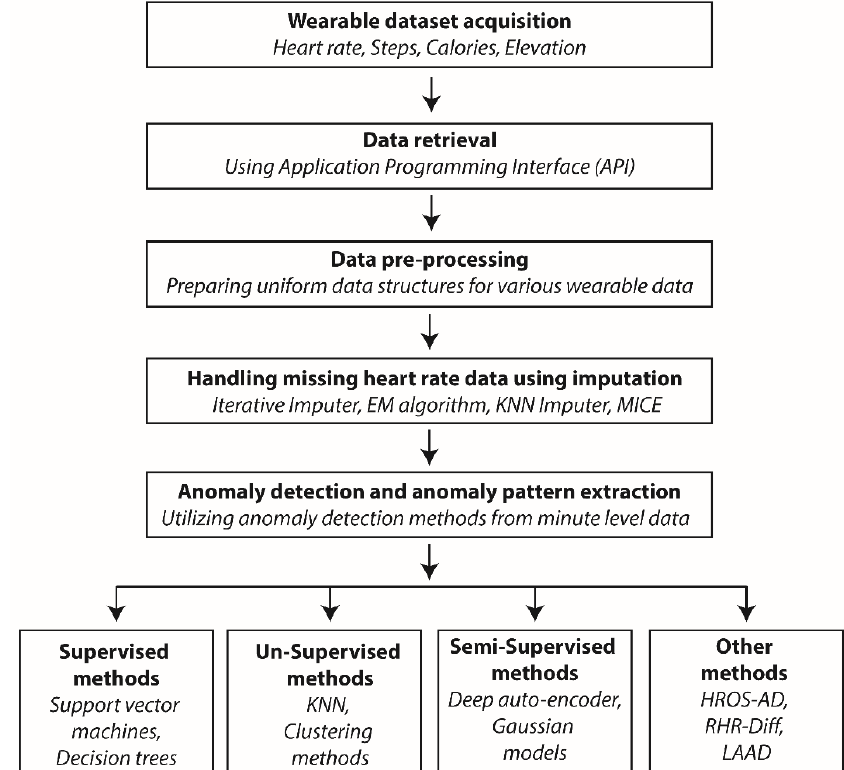
Figure 1. Flow chart describing a general anomaly detection workflow.